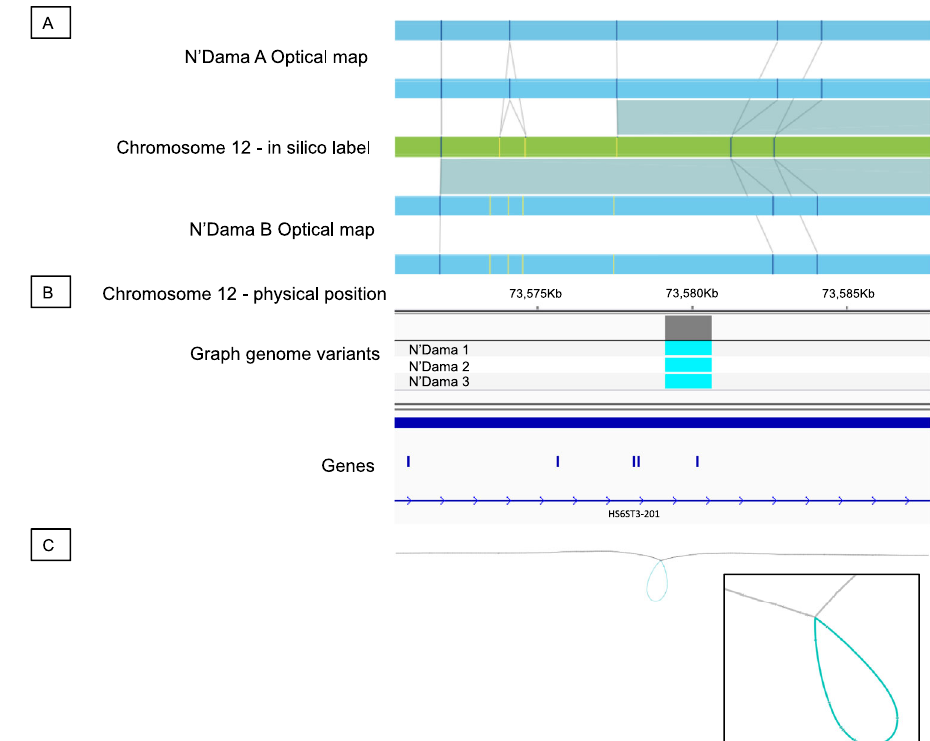
Fig. 5 Example of an insertion in the N ’ Dama relative to the Hereford reference. The insertion was detected A in both Kenyan N ’ Dama OM samples as represented by an increase in the distance between labels (vertical lines) on each bionano haplotype (blue rectangles) over that expected given the labels ’ in silico locations in the Hereford reference (green rectangle). B This SV was identi fi ed as homozygous in all three Nigerian N ’ Dama resequenced genomes when called against the graph genome. C A Bandage 76 representation of the graph genome in this region showing the large structural variant (blue loop) in the Hereford genome (grey line).